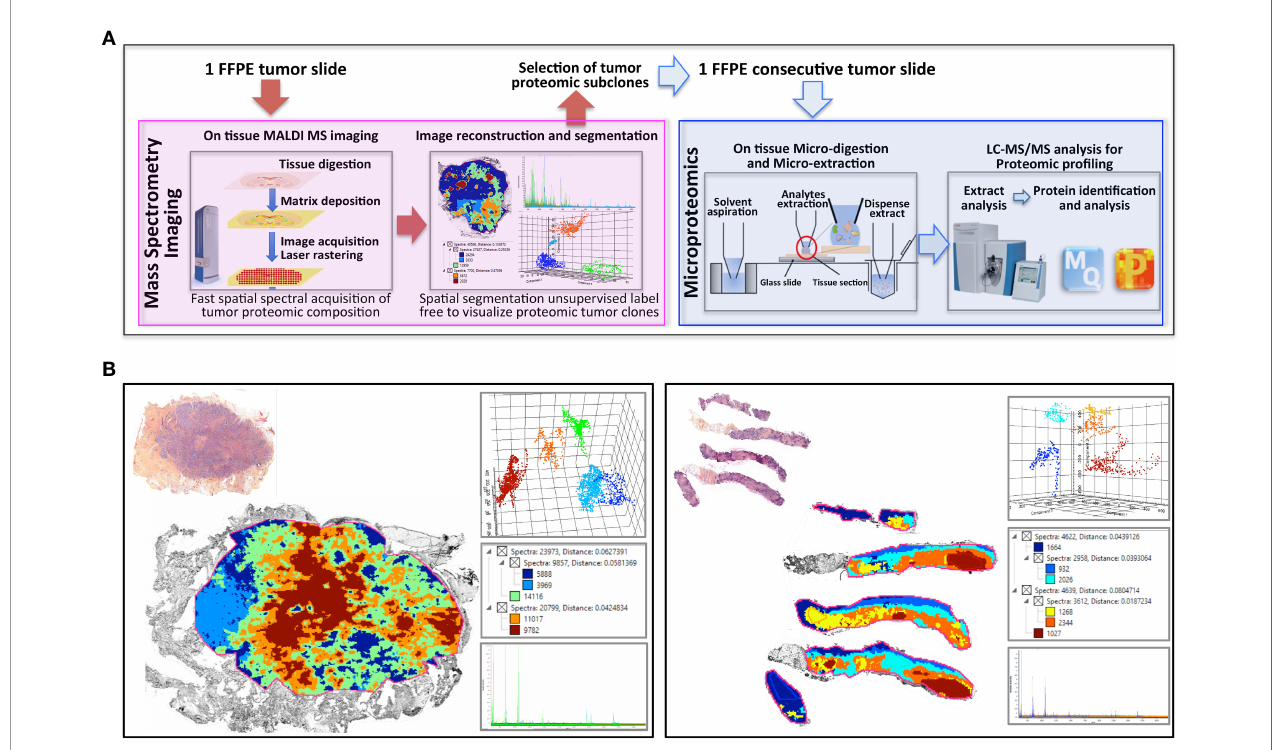
FIGURE 1 | Clonal proteome analysis in breast cancer. (A) Work fl ow for on tissue analysis of tumor proteomic heterogeneity using spatially resolved microproteomics guided by MALDI MSI (B) The presence of tumor proteomic clones revealed by MSI was illustrated in a primary tumor (left) from a surgical resection (case 42) and a metastatic sample (right) collected with a fi ne needle biopsy (case 22). In each sample vignette, the MALDI MS imaging is displayed with the histological HPS picture (upper left), the principal component analysis of the proteomic clones (upper right), the segmentation tree (middle right), and the spectra of the clones (bottom